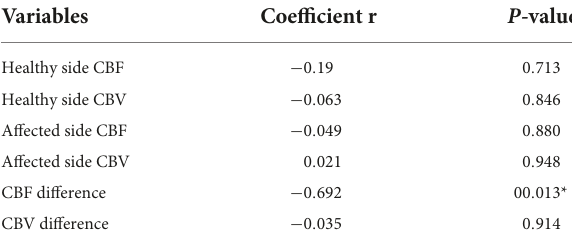
TABLE 4 Spearman correlation analysis of the relationship between the 24-h SBP SV and the CBF difference and CBV difference.